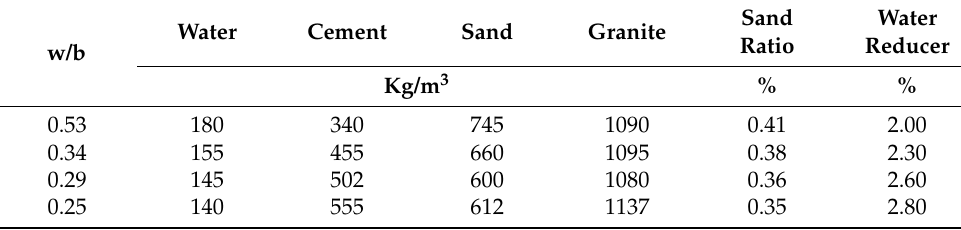
Table 4. Mix proportion of reference concrete.